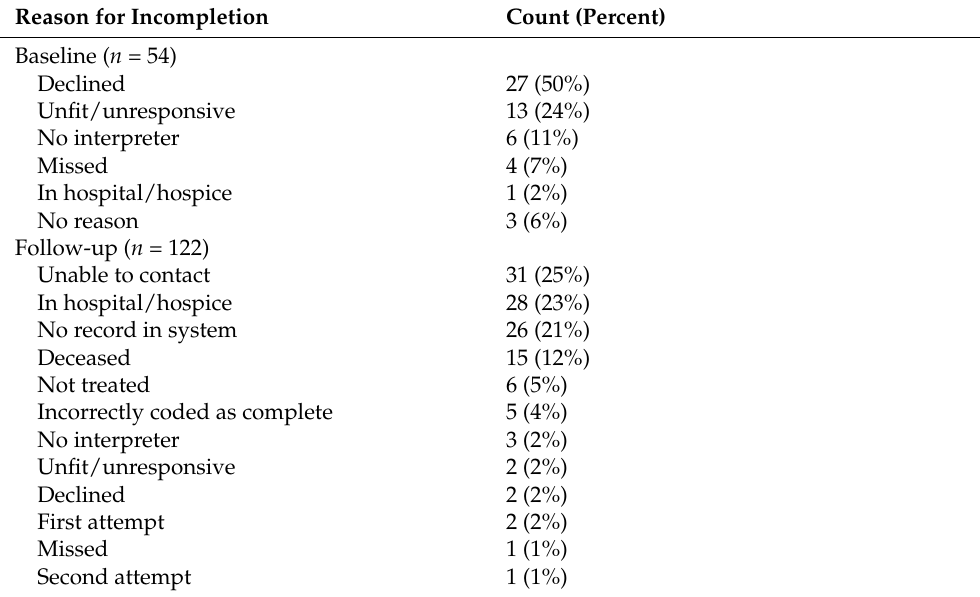
Table 2. Reason for incompletion.